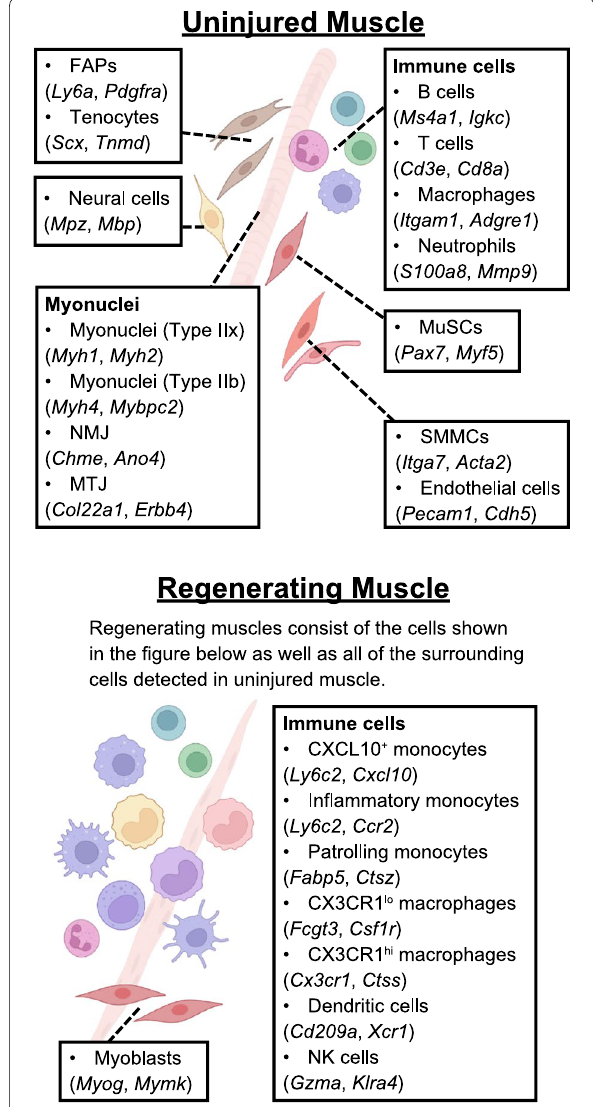
Fig. 2 Cellular diversity of skeletal muscle identified by single-cell RNA sequencing. Single-cell RNA sequencing analysis has revealed the detailed cellular composition of adult skeletal muscle and the molecular signature of each mononuclear cell type. This method has not only confirmed the previously established marker-based cell populations (MuSCs, FAPs, immune cells, ECs, pericytes, and neurons) but has also begun identifying new populations of tenocytes and rare cell subpopulations. Further functional analysis will reveal how each of these populations regulates skeletal muscle regeneration, leading to a better understanding of the pathophysiology of sarcopenia and fibrosis caused by regeneration defects. NMJ: neuromuscular junction; MTJ: myotendinous junction; SMMC: Smooth muscle-mesenchymal cell. Created with BioRe nder.